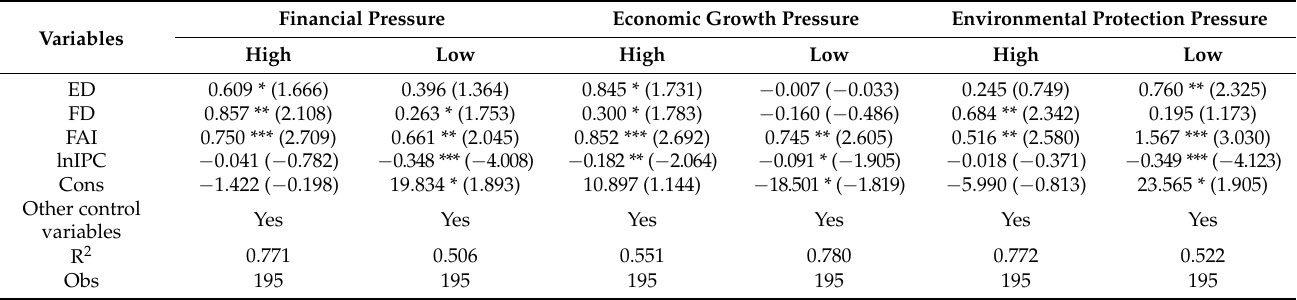
Table 7. Subregional estimation